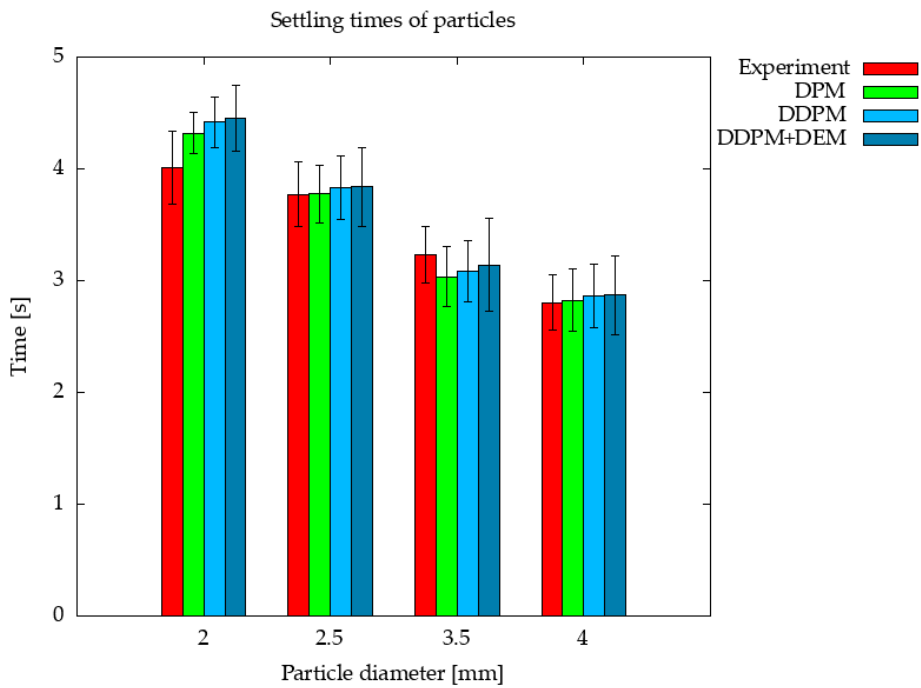
Figure 7. Average settling times of plastic particles; error bars represent one standard deviation.